Question: What style of plot is this figure drawn as?
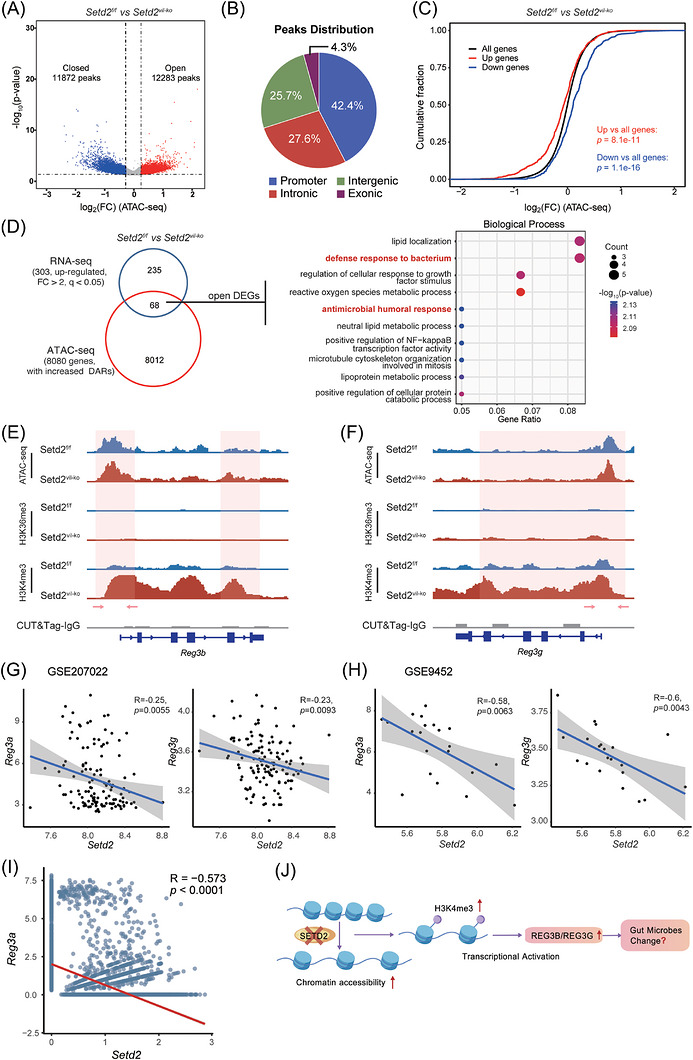
Answer: scatter